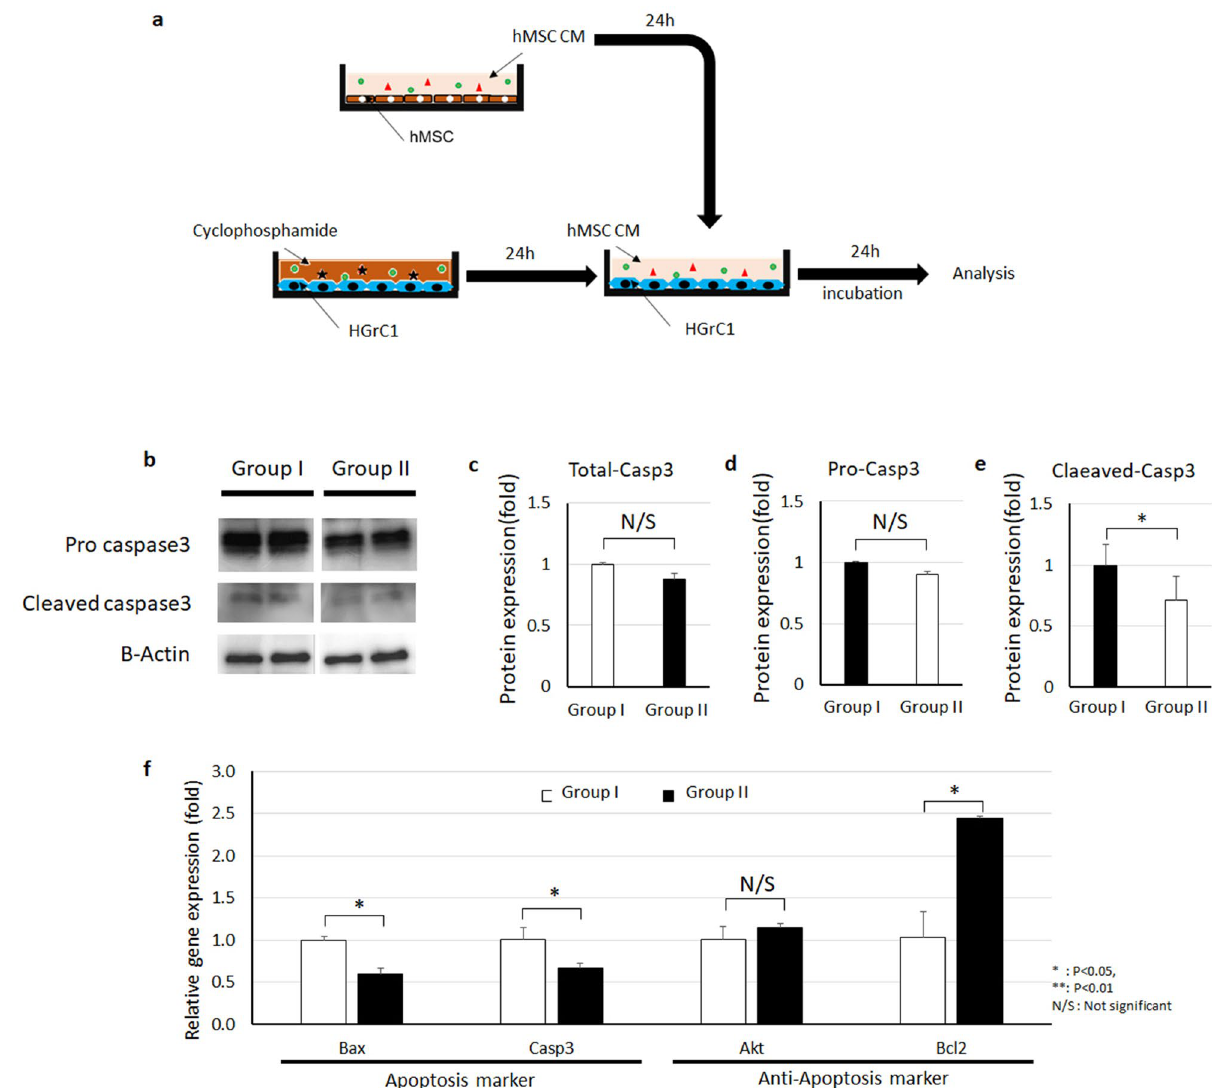
Figure 1. Human mesenchymal stem cell conditioned media (hMSC CM) decreases cyclophosphamide- induced apoptosis of human granulosa cells (HGrC1). ( a ) Experimental design of the in vitro study. ( b – e ) Expression of apoptosis marker caspase 3 by immunoblot in cyclophosphamide-treated HGrC1 that were untreated (control, Group I) or treated with hMSC CM (Group II). Quantification of total caspase 3 ( c ), pro- caspase 3 ( d ), and cleaved caspase 3 ( e ) based on immunoblot protein band density. ( f ) Apoptosis marker gene expression in cyclophosphamide-treated control HGrC1 (Group I) and hMSC CM-treated HGrC1 (Group II). Two biological replicates per treatment group were analyzed in duplicate (* P < 0.05, ** P < 0.01, N/S not